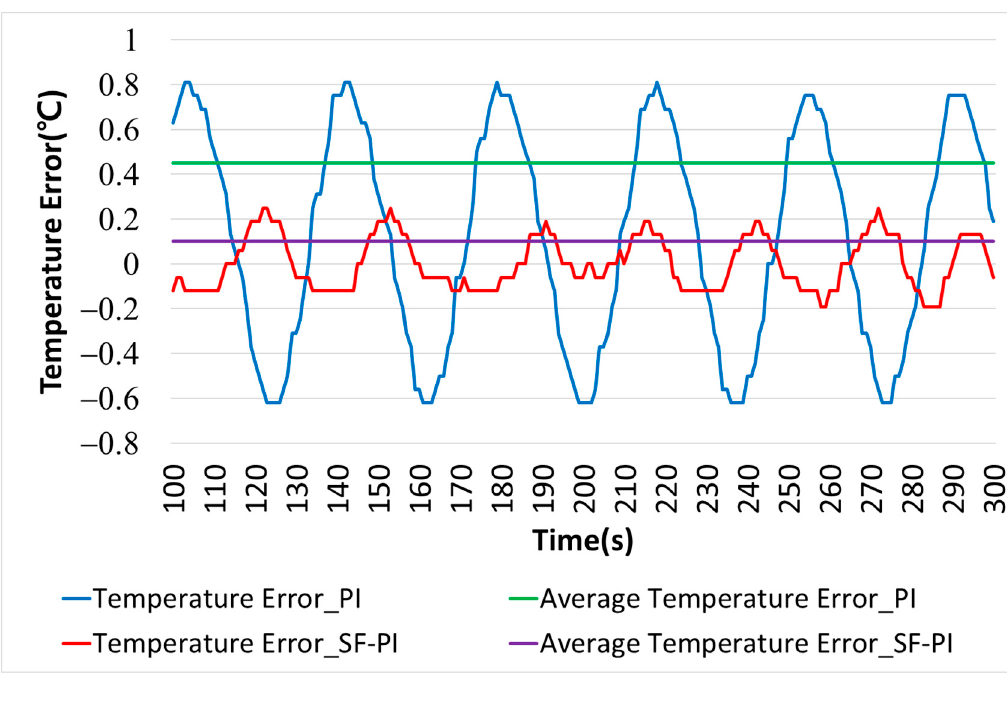
Figure 15. Temperature error comparison. Table 8. Temperature error comparison.